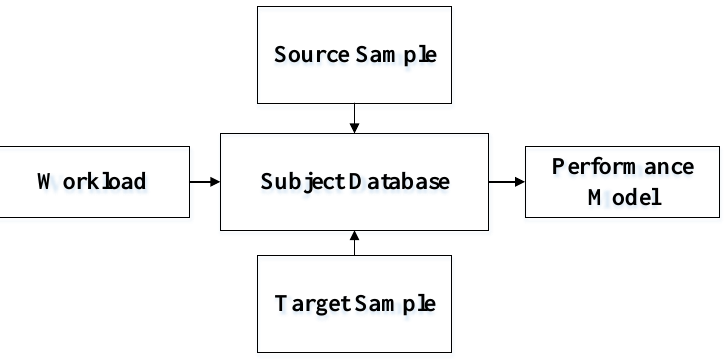
Figure 1. Problem overview of performance modeling across different database